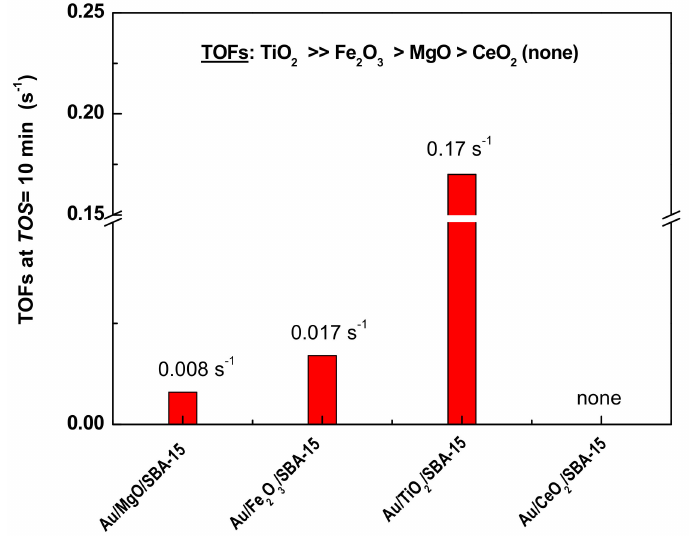
Figure 11. Comparison of the TOFs values of the calcined Au/MO x /SBA-15 catalysts tested in the CO oxidation reaction. Reaction conditions were: T = 20 ◦ C, atmospheric pressure, TOS = 10